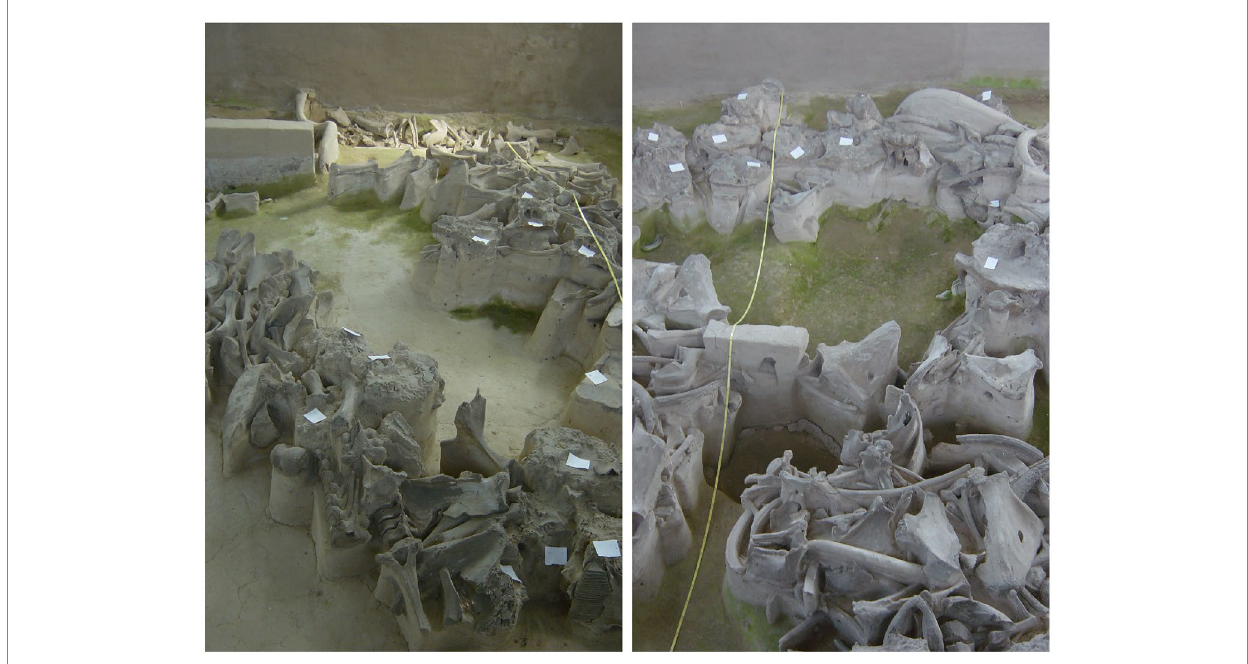
FIGURE 7 Upper Paleolithic mammoth bone complex. Left: Mammoth bone structure #4 at the Epigravettian Yudinovo site, Russia (image credit: M. Germonpré). Right: Mammoth bone structure #3 at the same site (image credit: M. Germonpré).